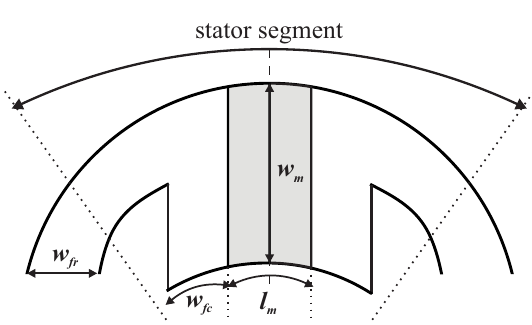
Figure 4. Cross-section of a stator segment with the corresponding parameters.